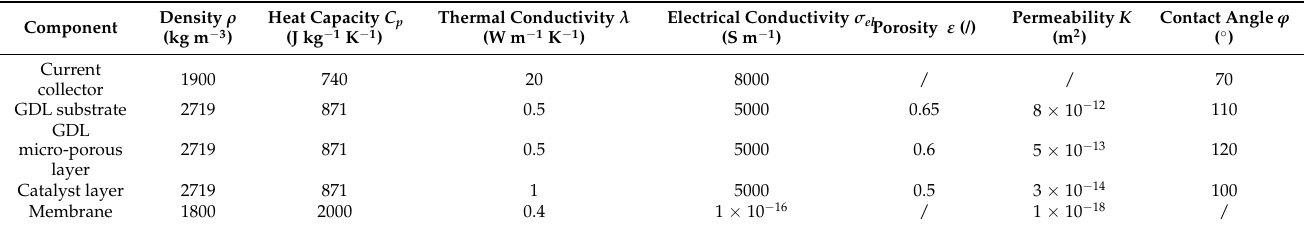
Table 2. Properties of PEM fuel cell components.